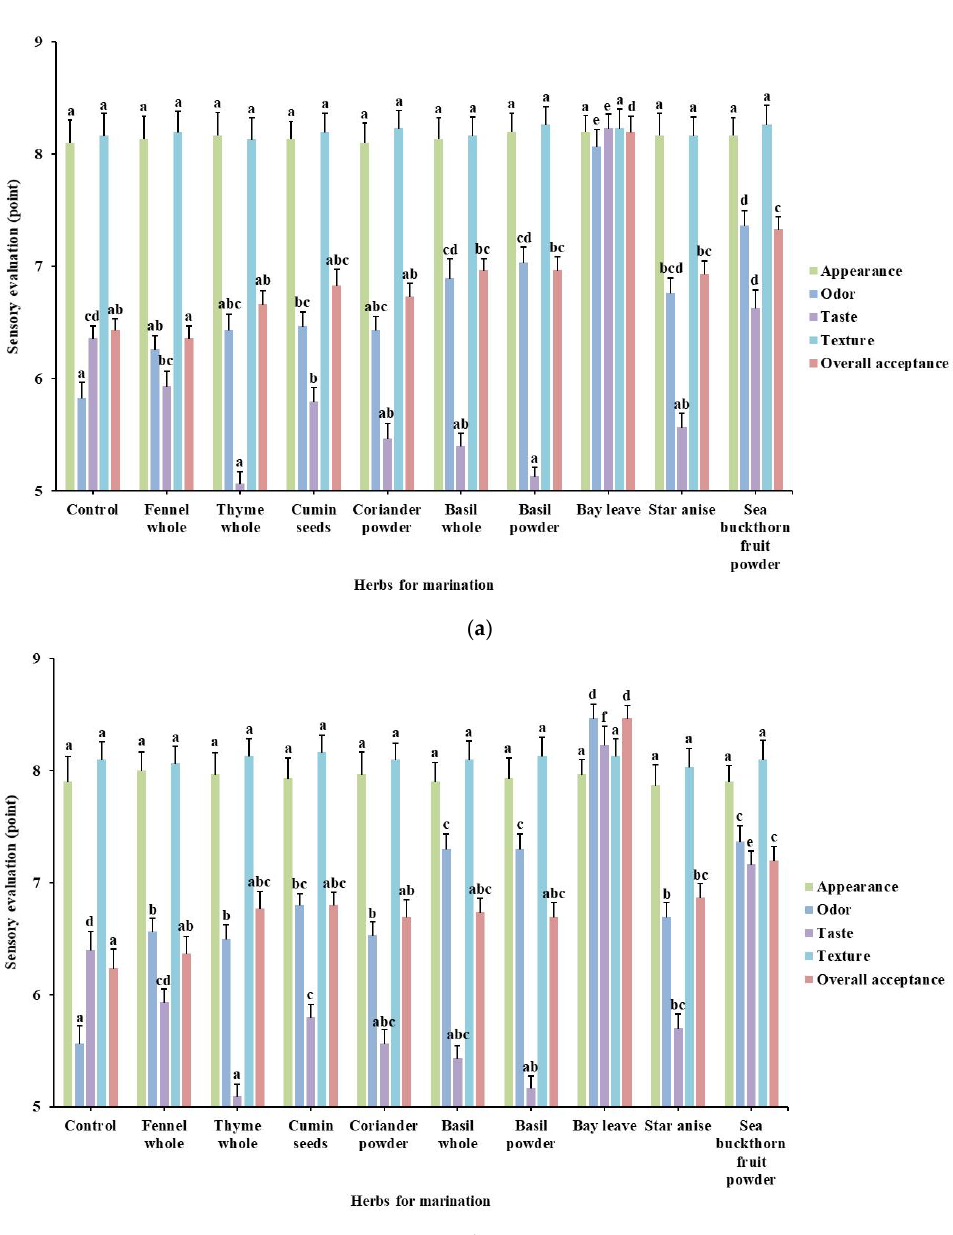
Figure 4. Sensory evaluation of marinated chicken leg and breast with different herbal extract solutions: ( a ), chicken leg; ( b ), chicken breast. Values are mean ± SE. Different letters (a–f) in the respective colored column indicate significant differences among the means by Tukey’s test ( p < 0.05).